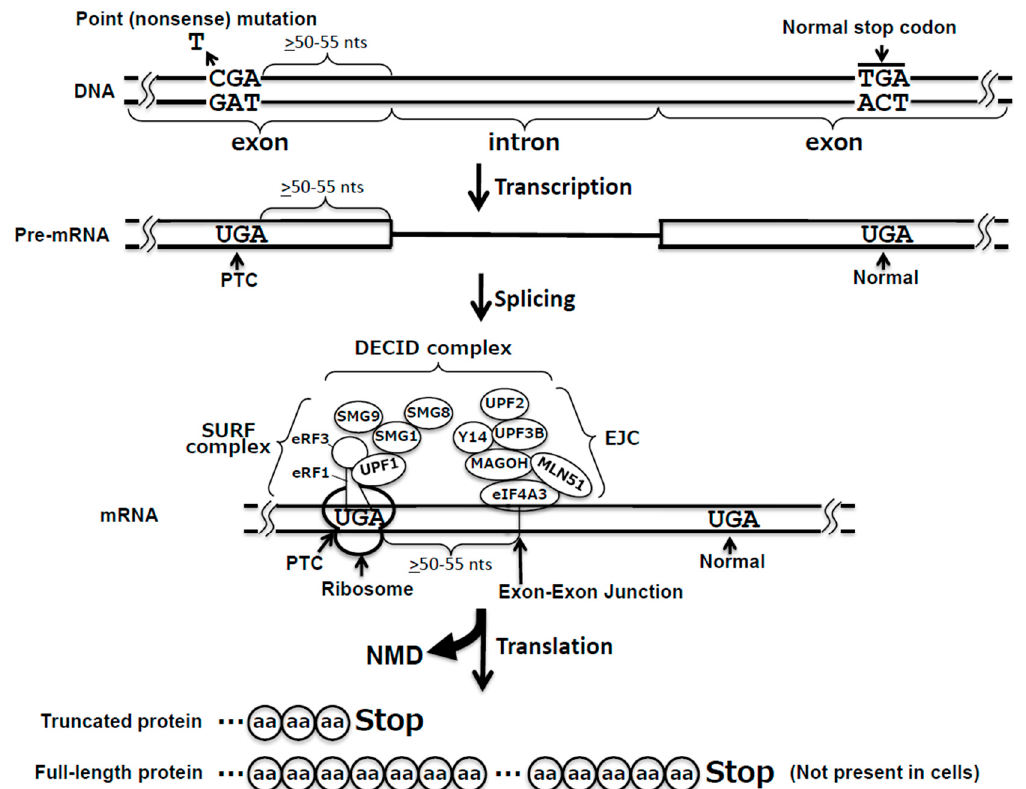
Figure 1. Nonsense mutation and its consequences. A point mutation (indicated) occurs in a gene, creating a premature termination codon (PTC) at the site > 50–55 nts upstream of the exon–intron junction (indicated). After transcription, the nonsense mutation is passed onto pre-mRNA. Upon splicing, an exon–exon junction complex (EJC) forms (indicated). When the ribosome encounters the PTC, the eRF1–eRF3 complex enters the ribosome and recruits a number of factors to form the SMG1 / UPF1 / eRF1 / eRF3 (SURF) complex. Together, EJC–SURF combination is called the decay-inducing (DECID) complex. Consequently, nonsense-mediated mRNA decay (NMD) is activated, and the mRNA is degraded. A small fraction of mRNA that escapes degradation is translated, but translation terminates at the PTC, generating a truncated protein (indicated). The normal stop codon is also indicated, and if the PTC is absent, translation will terminate at the normal stop codon, generating a full-length protein (also shown). DNA, pre-mRNA, mRNA, the exons and intron, and the amino acid protein chains are indicated.